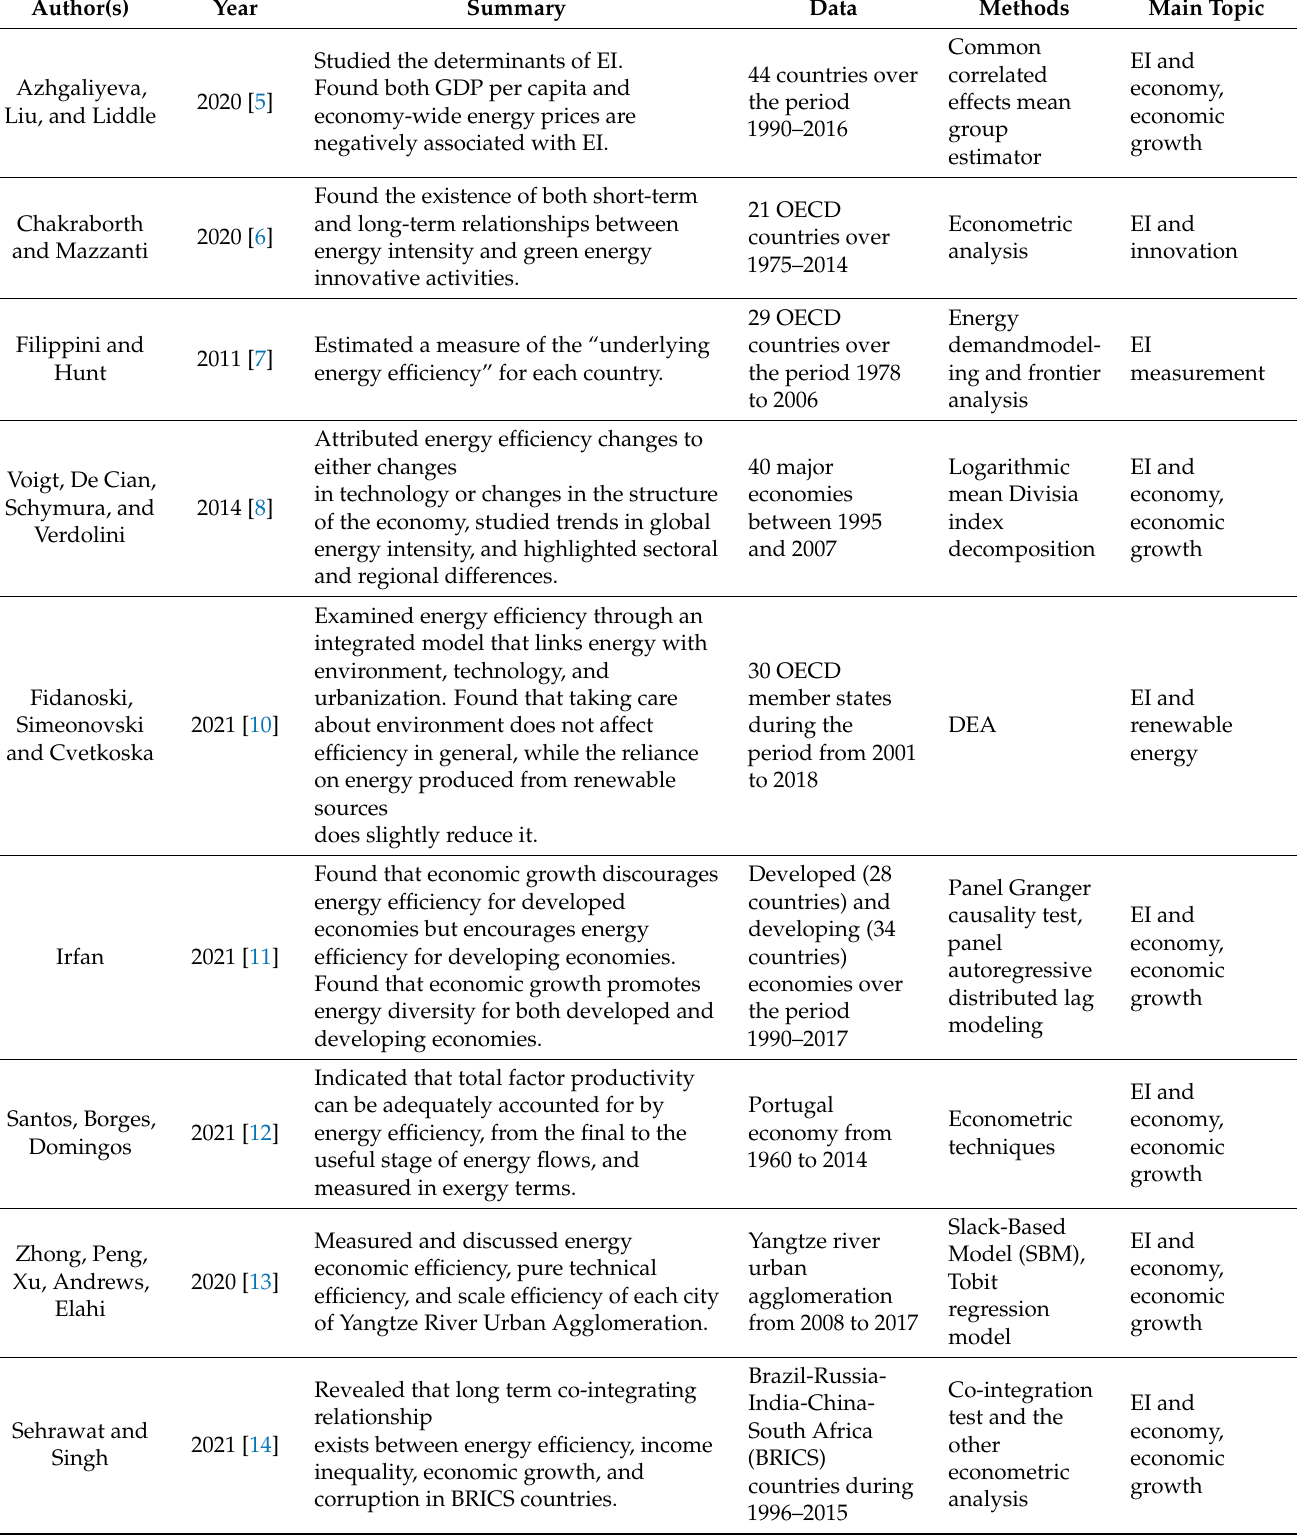
Table 1. References on EI and economic growth